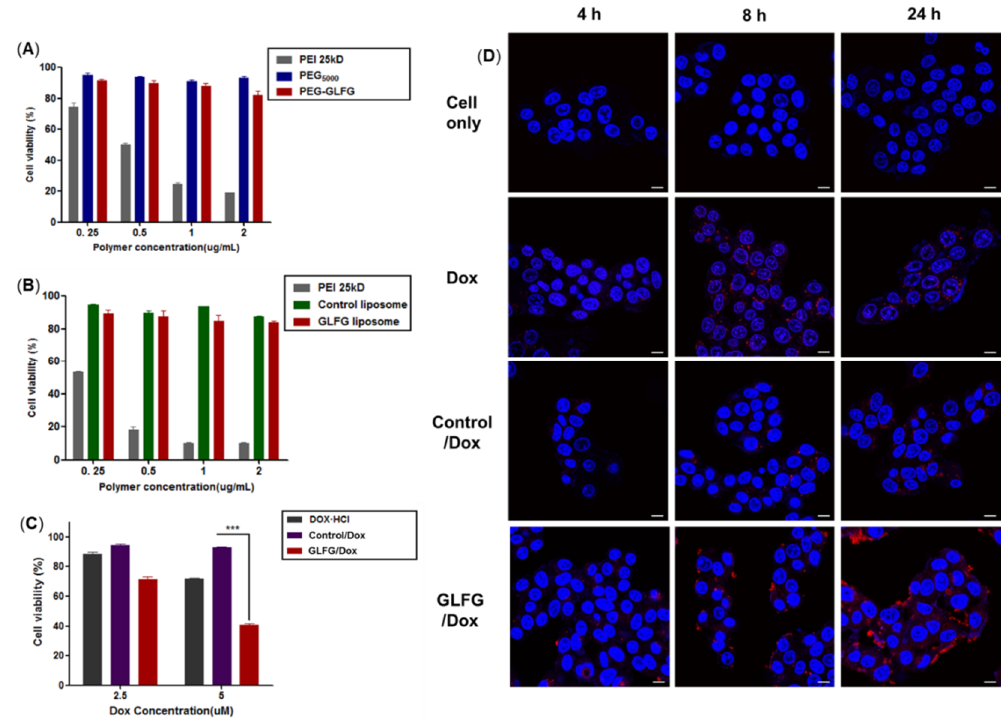
Figure 5. Evaluation of cytotoxicity for ( A ) PEG-GLFG and ( B ) GLFG liposomes. ( C ) Anticancer effects of GLFG/Dox in Hep G2 cells. ( D ) Cellular uptake of GLFG/Dox was observed using confocal microscopy. Nucleus (Blue, Hoechst33258), Dox (Red). The samples were treated using 5 μM of Dox. (scale bar: 10 μm) .